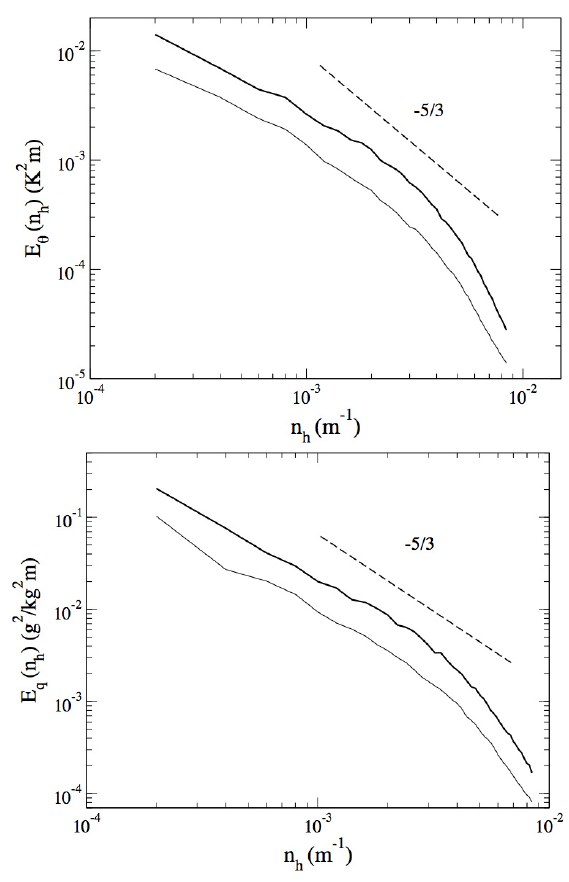
Fig. 10. The same as Fig. 9, but for the potential temperature and for the humidity fields. The dashed line gives the Kolmogorov slope for the inertial range of